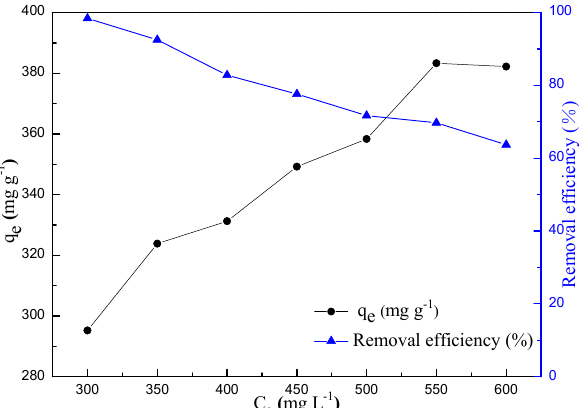
Figure 7. Adsorption capacity and removal efficiency vs. initial MB concentrations on BSNC-800-4;